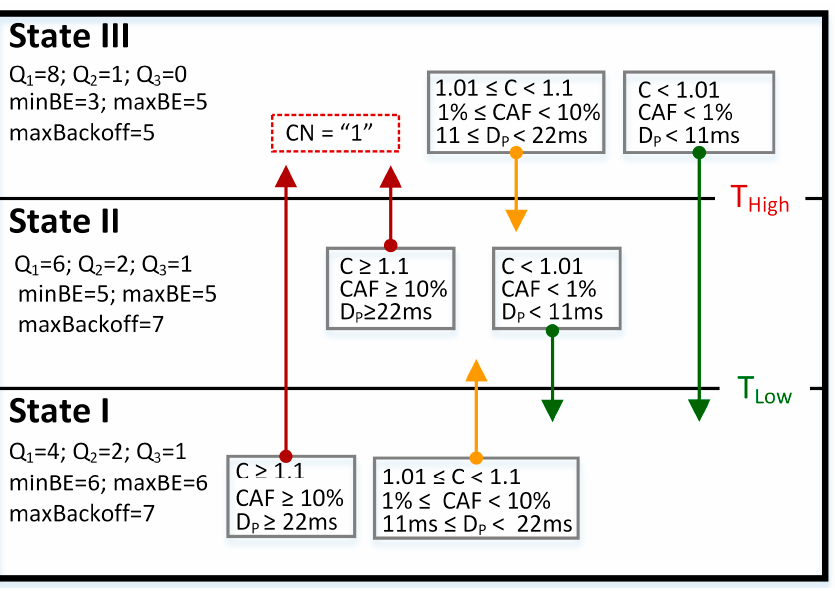
Figure 6. Key values for the operation of QCCP.